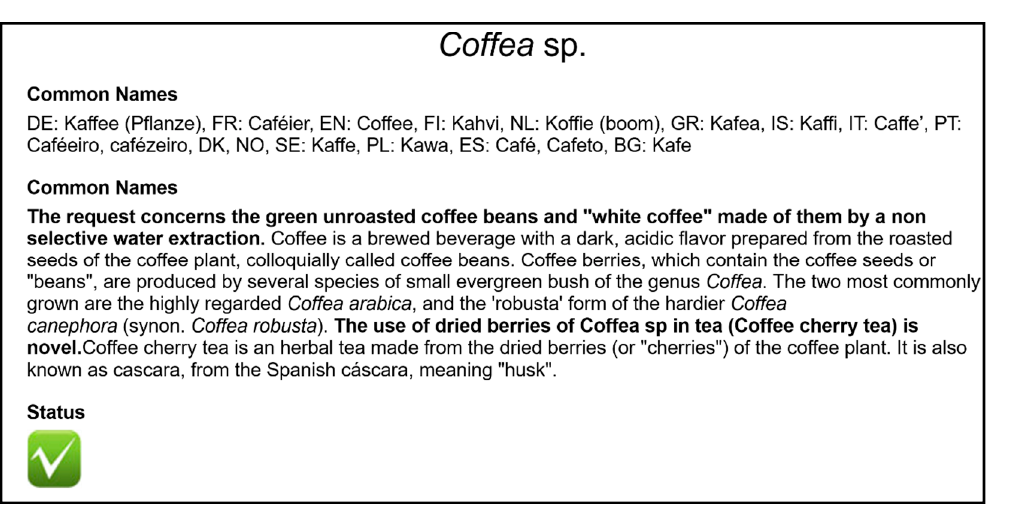
Figure 1. European Union (EU) Novel Food Catalogue entry for Coffea (accessed on 31 March 2020) [10].